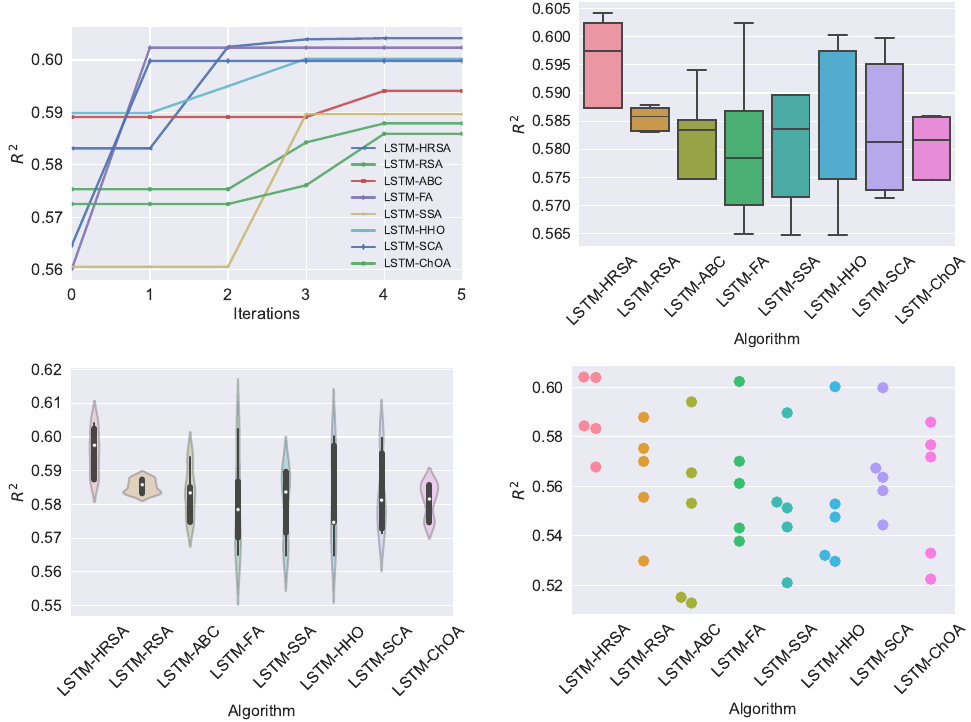
Figure 5. Visual LSTM simulations for each of 8 optimization methods with respect to the convergence, box plot, violin diagrams, and swarm diversity diagrams of the R 2 criterion.